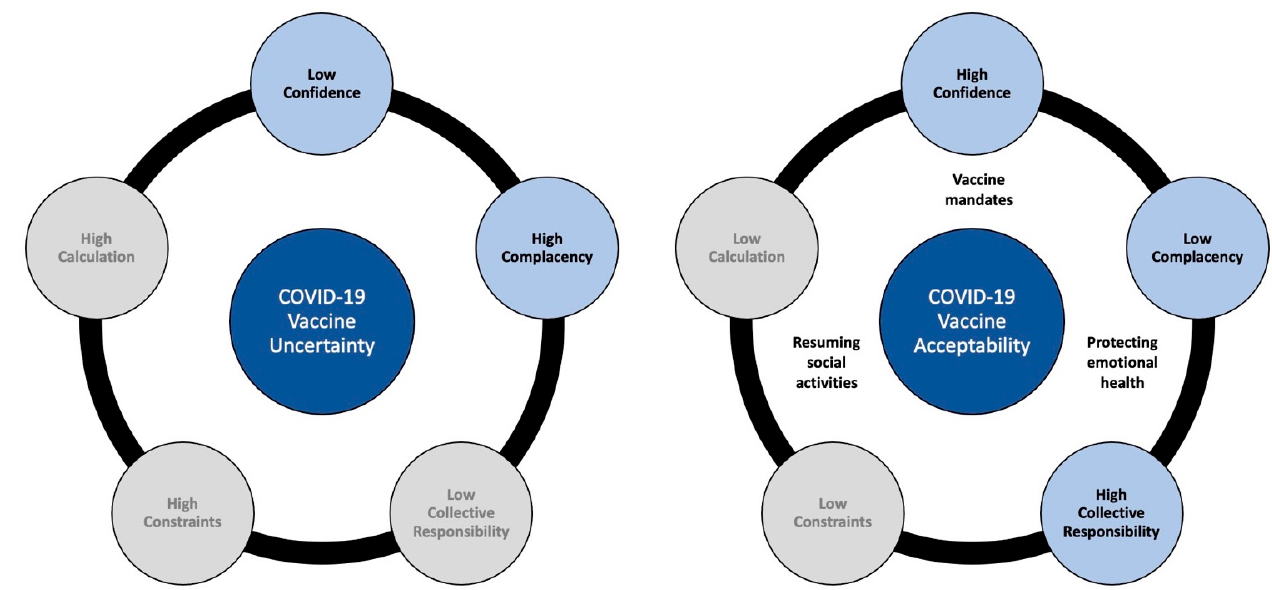
Figure 5. Graphical Representation of Qualitative